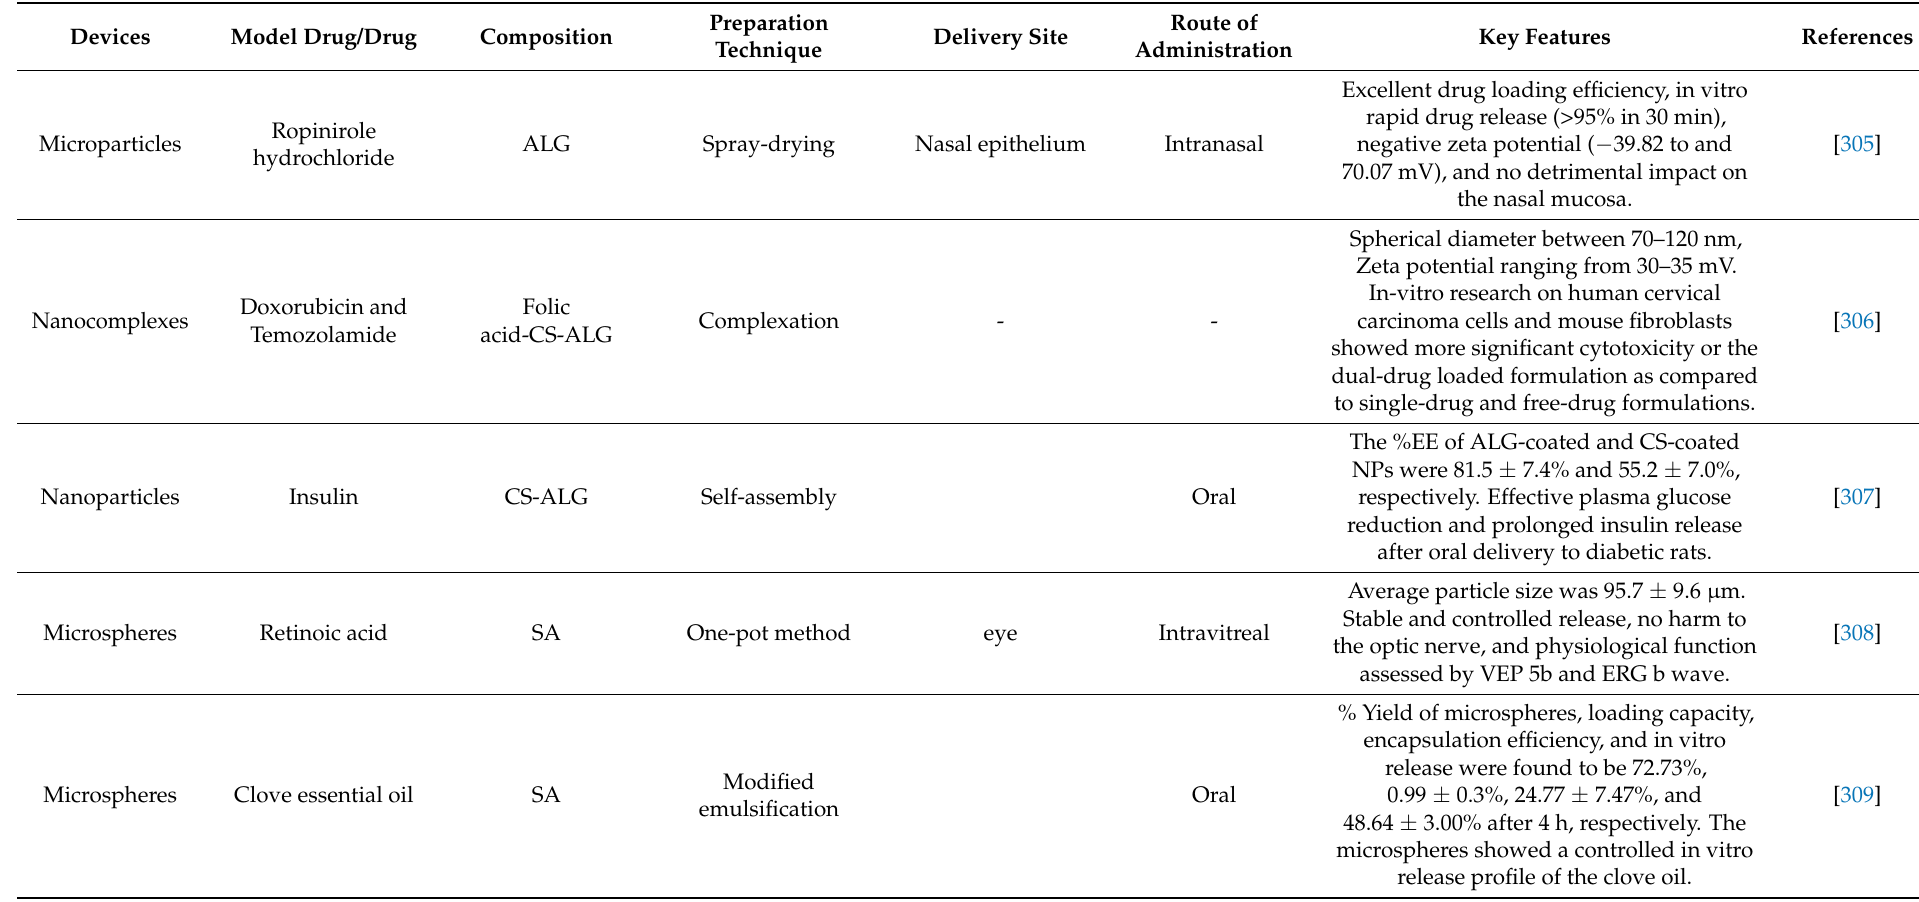
Table 2. Recent research on ALG-based formulations for improved actives